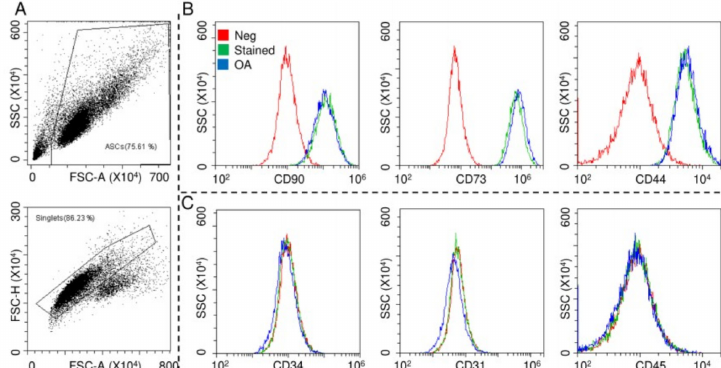
Figure 1. Surface marker expressions of adipose-derived MSCs (ASCs). After FSC / SSC gating and doublets removal ( A ), ASCs without and with osteoarthritis (OA) inflammation resulted positive for CD90 / 73 / 44 MSC markers ( B ) and negative for CD34 / 31 / 45 hemato / endothelial determinants ( C ). Red: unstained ASCs, green: stained ASCs and blue: stained inflamed (OA) ASCs. Representative cytograms of a single population are